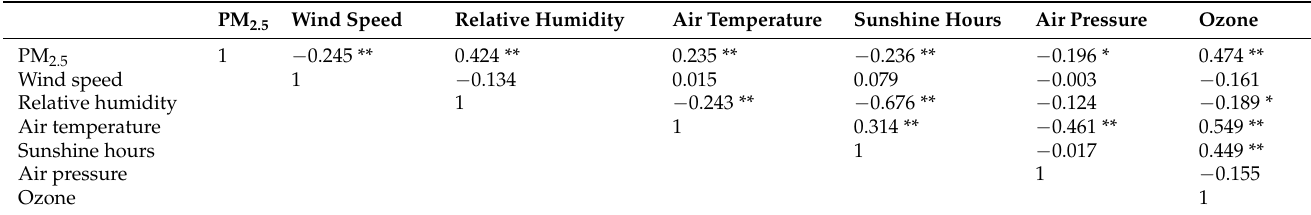
Table 2. Spearman correlation among daily means of PM 2.5 , ozone, and meteorological parameters